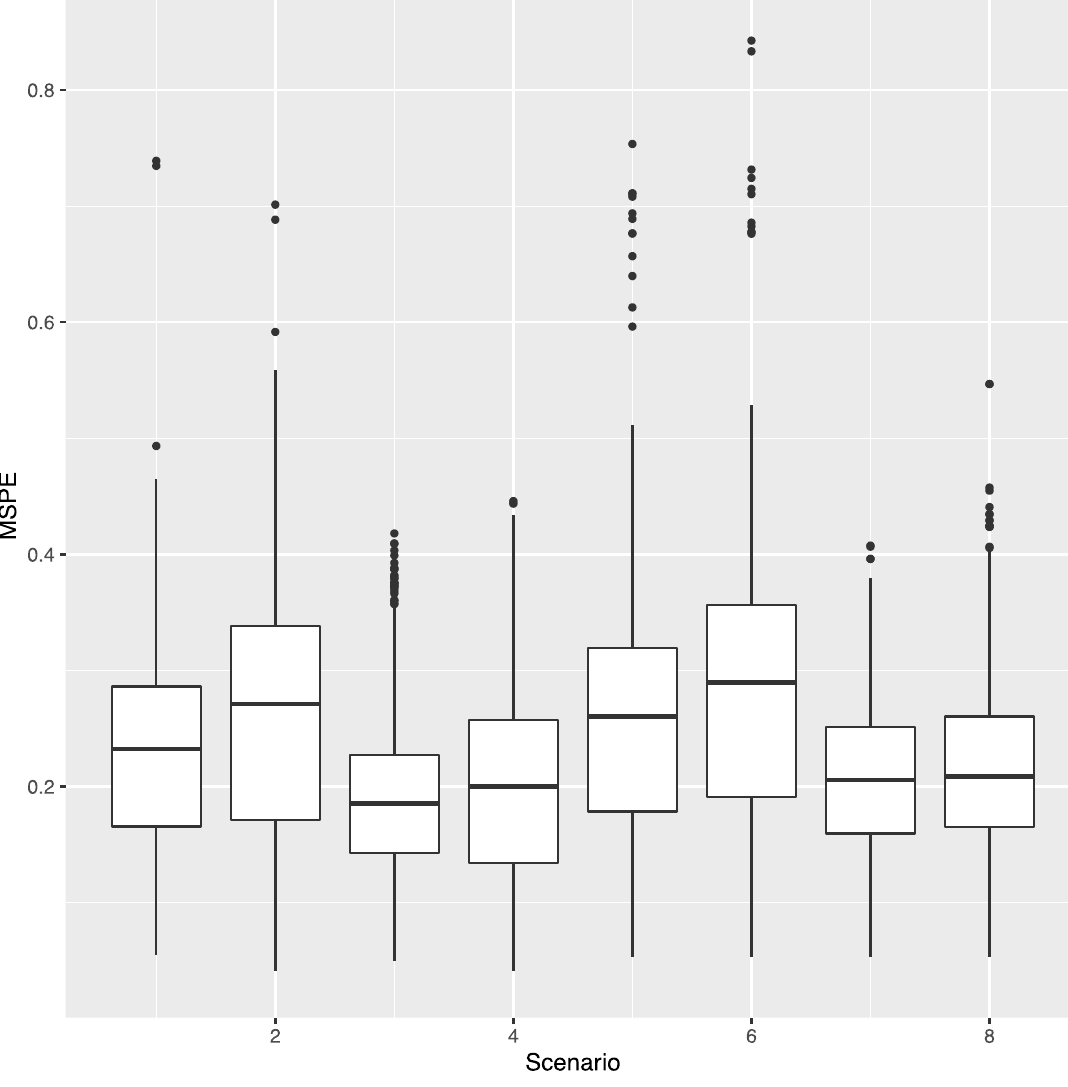
Figure 4. Boxplot of the MSPE for the eight scenarios. Each boxplot represents the distribution of the MSPE values over all methods and events. The black dots are outliers.